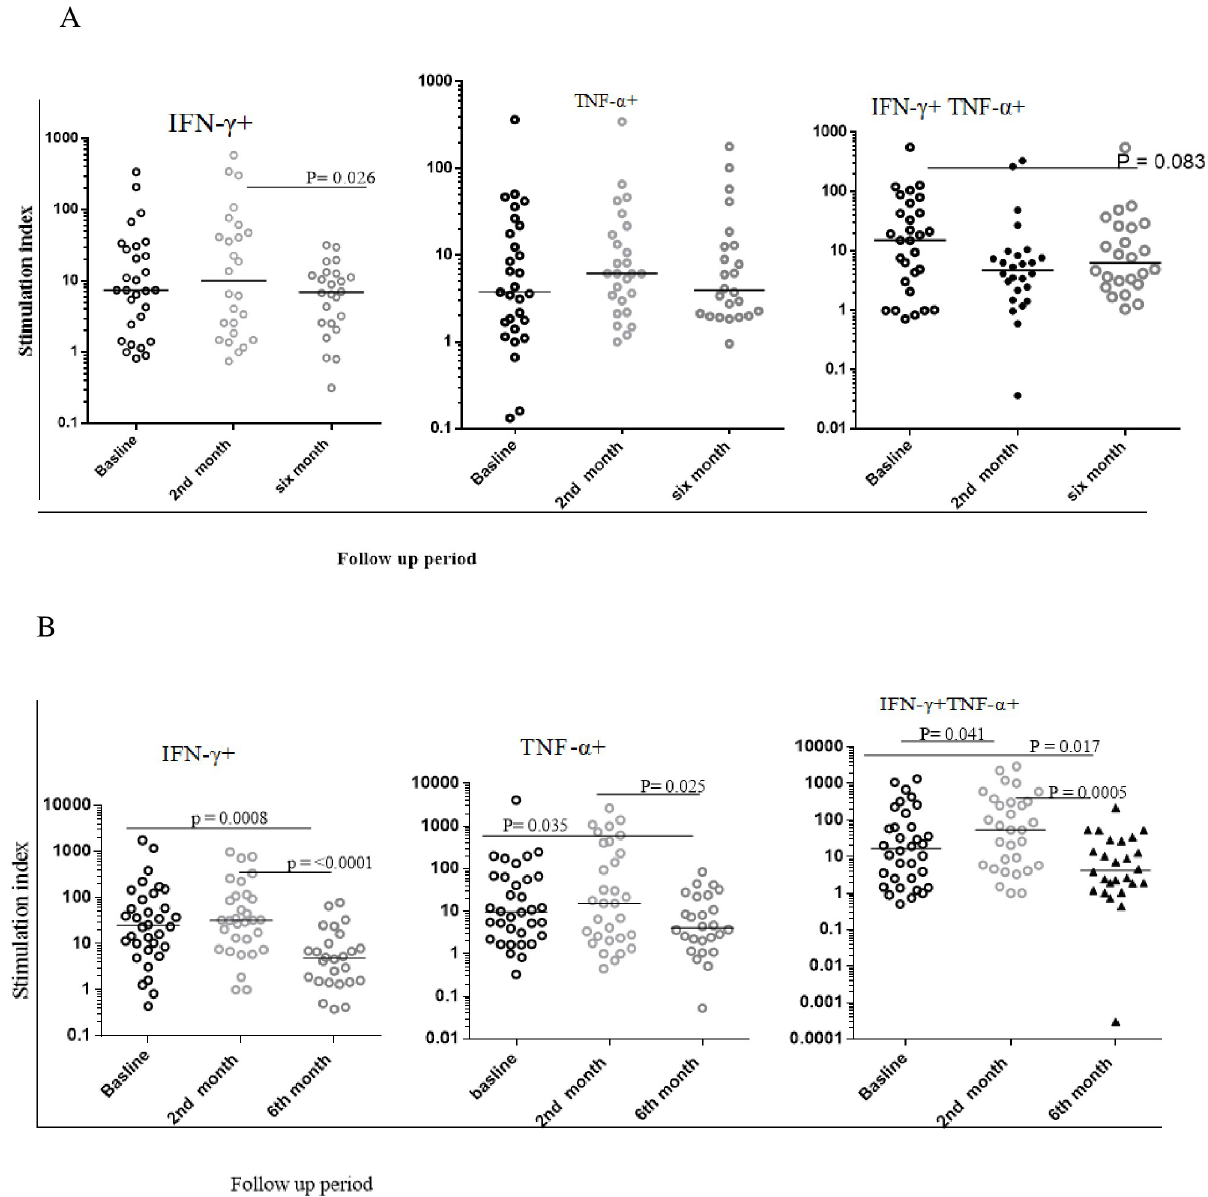
Fig 3. Level of expression of activation and proliferation markers from PPD specific IFN- γ + CD4 + T cells and TNF- α + CD4 + T cells during the standard anti-TB treatment follow up using fresh PBMC samples. A:—the level of activation and proliferation markers expression from IFN- γ + CD4 + T cells among smear negative PTB patients. B:—the level of activation and proliferation markers expression from TNF- α + CD4 + T cells among smear negative PTB patients. C:—the level of activation and proliferation markers expression from IFN- γ + CD4 + T cells among smear positive PTB patients. D:—the level of activation and proliferation markers expression from TNF- α + CD4 + T cells among smear positive PTB patients. Stimulated indices were calculated as the frequency of marker positive/cytokine positive cells cultured in the presence of PPD divided by that in the absence of PPD. The bars within each plot indicate the median value for each marker and time point. Data analysis was done using non-parametric Wilcoxon matched-paired rank test with significant p values indicated. Baseline represents values prior to initiation of standard anti-TB drugs. 2 nd and 6 th month refers to time after therapy